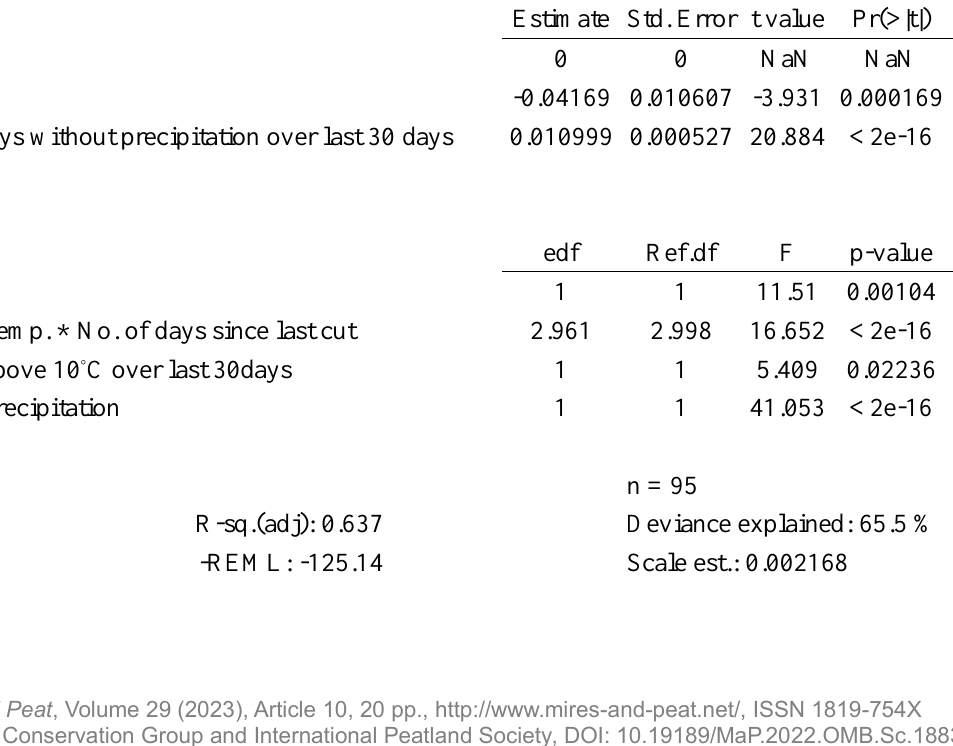
Table A4. Performance of the generalised additive model used for predictions of crude protein content in protein precipitate. Significance codes: * = p < 0.05; ** = p < 0.01; *** = p <